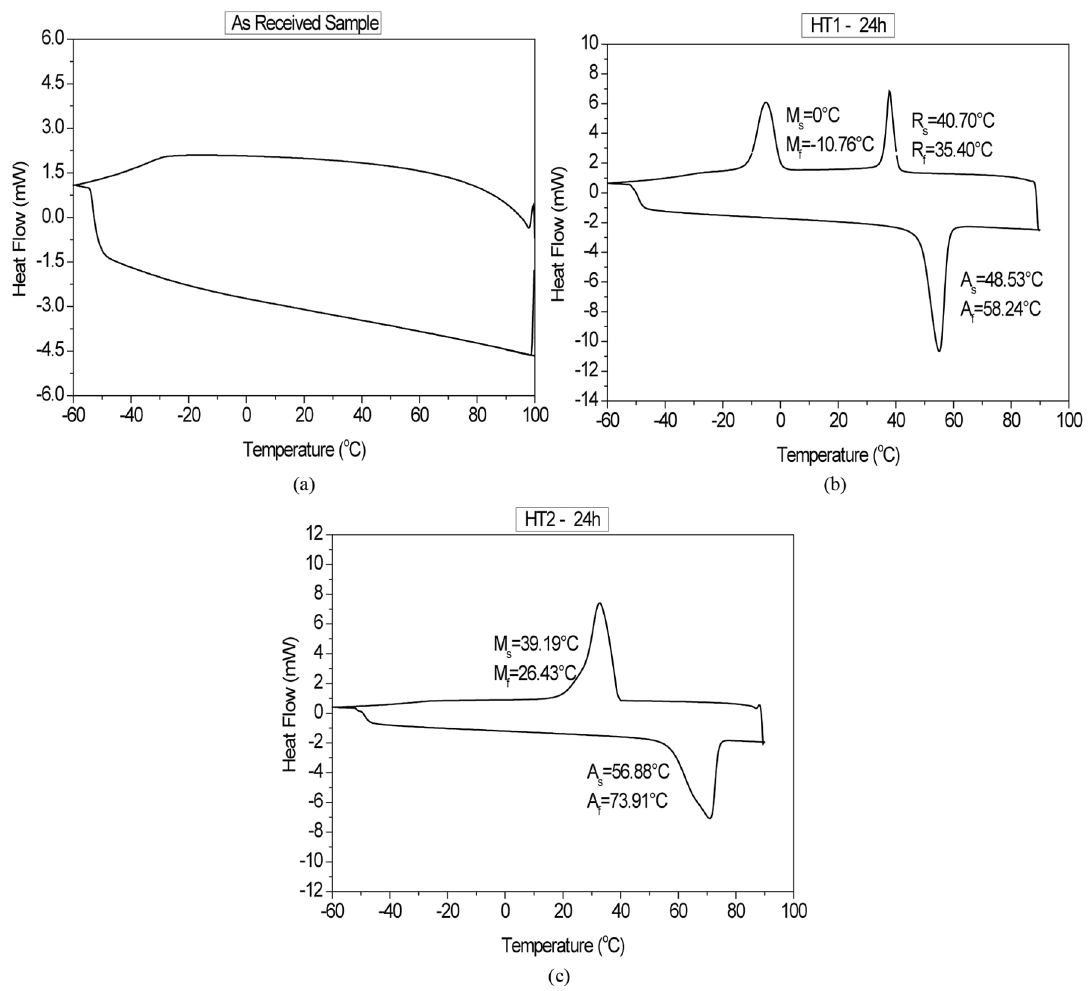
Figure 2. Calorimetric curves of samples: (a) as-received condition, (b) HT1-24h and (c) HT2-24h.